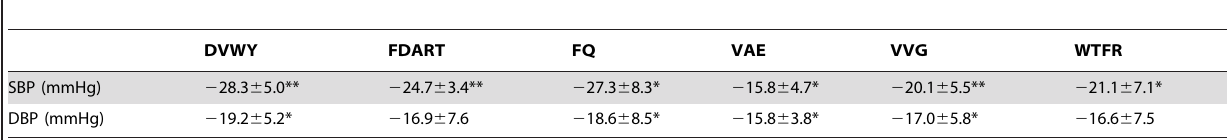
Table 2. Maximum systolic and diastolic blood pressure pressure-lowering values at 6 h after administration of FBPs to SHRs (10 mg/kg BW, n =6).